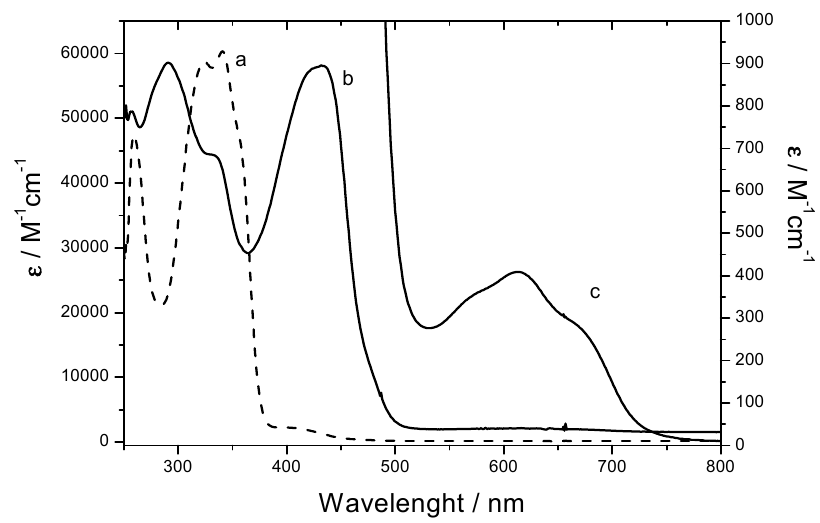
Figure 3. UV-Vis spectra of a solution of 3,7-dihydroxyflavone in ethanol ( a ); a solution of [Cr(3,7-diHF) 3 ] in dimethyl sulfoxide ( b , c ).